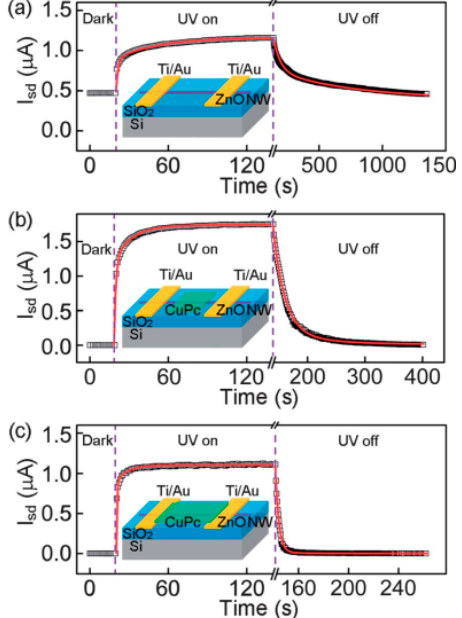
Figure 3. ( a ) The photoresponse curve of the bare ZnO nanowire device, ( b ) the partial coverage device, ( c ) the full coverage device. The insets are schematic diagrams of corresponding devices, respectively. The photoresponses of three devices with different CuPc coverage were measured at bias voltage of 0.5 V, and the UV illumination source was 350 nm light with intensity of 100 uW·cm − 2 . [56].